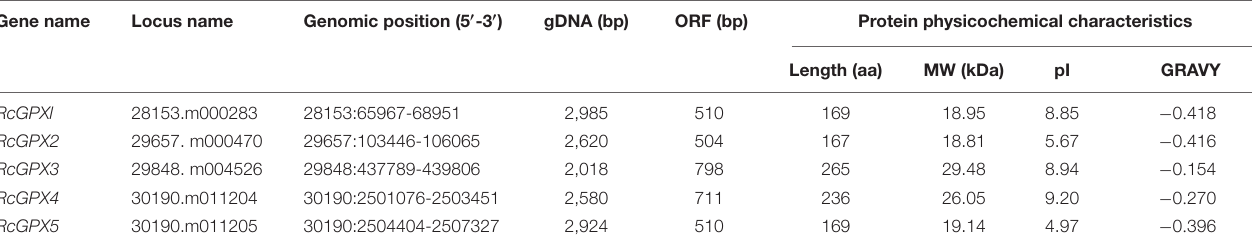
TABLE 1 | Information on five RcGPXs identified in the Ricinus communis genome.